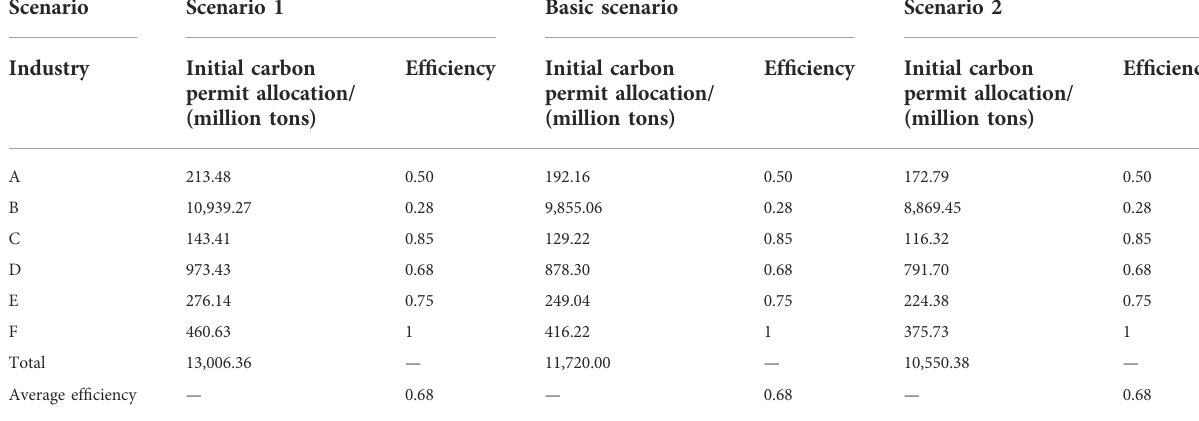
TABLE 5 Initial carbon permit allocation of six